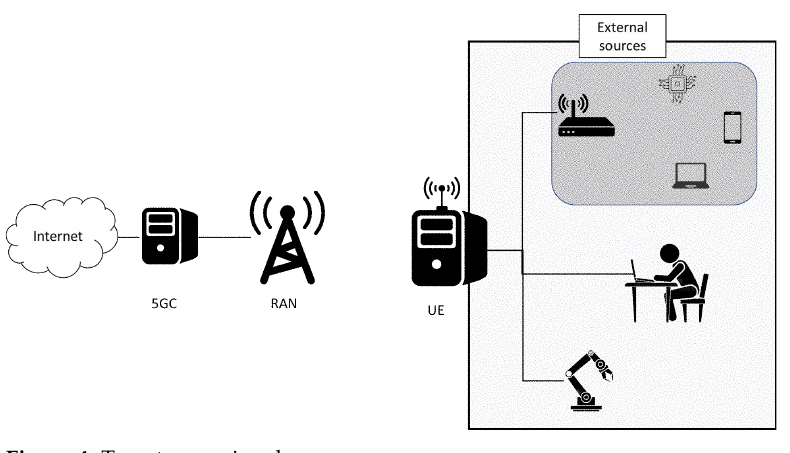
Figure 4. Target scenario